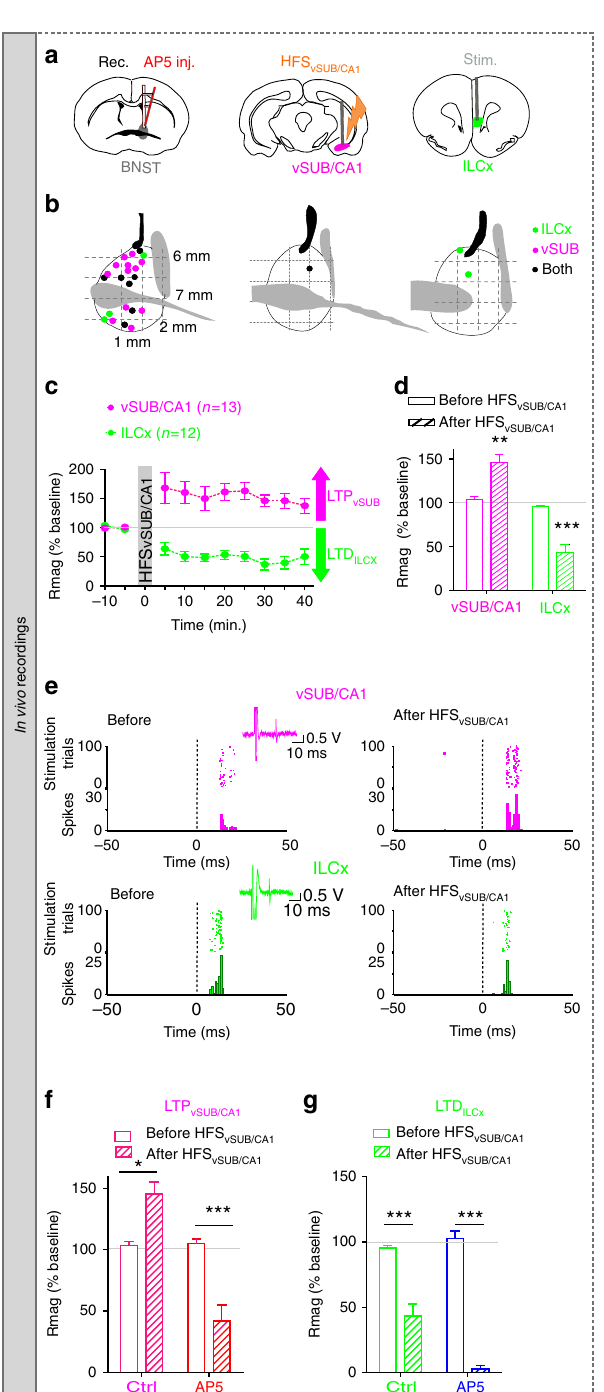
Figure 3. | In vivo input-specific opposite plasticity in the amBNST. ( a ) Experimental protocol. ( b ) Cartography of recording sites in the BNST. Neurons which have been tested for the ILCX are represented in green, those tested for the vSUB are in magenta and those tested for both inputs are in black. ( c , d ) Kinetic ( c ) and quantification ( d ) of the mean percentage change ( ± s.e.m.) in vSUB/CA1 (magenta) and ILCx (green) evoked spike probability, normalized to the baseline, after HFS vSUB/CA1 . Rmag, excitatory response magnitude. ( e ) Typical PSTHs ( þ rasters) illustrating responses of a same single-BNSTneuron before (left) and after (right) HFS vSUB/CA1 on the vSUB/CA1-amBNST pathway (top) and on the ILCx-amBNST pathway (bottom). Stimulus: t0 (gray lines). Bin width: 1ms. Traces in insets. ( f , g ) Quantification of the mean percentage change ( ± s.e.m.) in the vSUB/CA1 spike probability ( f ) or in ILCx spike probability ( g ) in control condition or after AP5 infusion in the